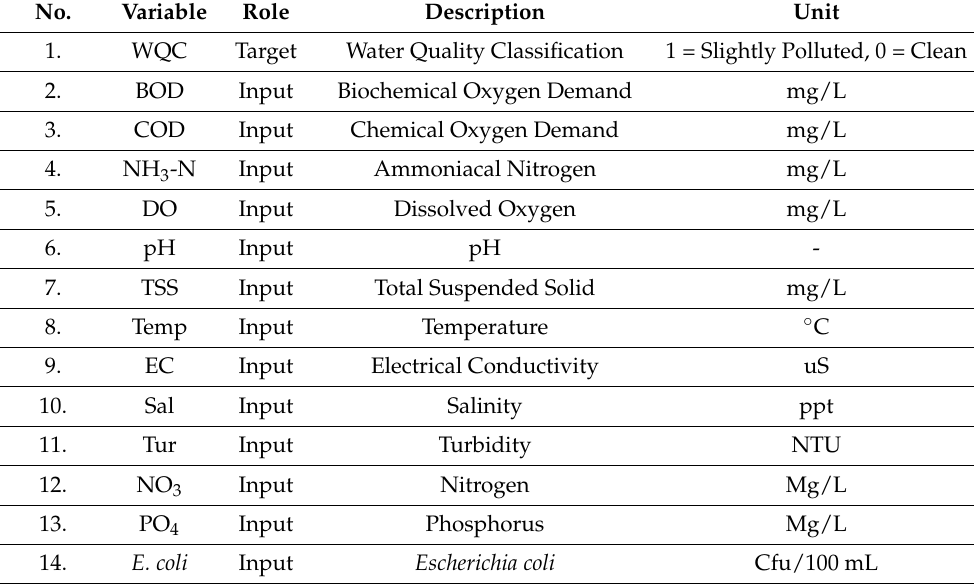
Table 3. Description of the